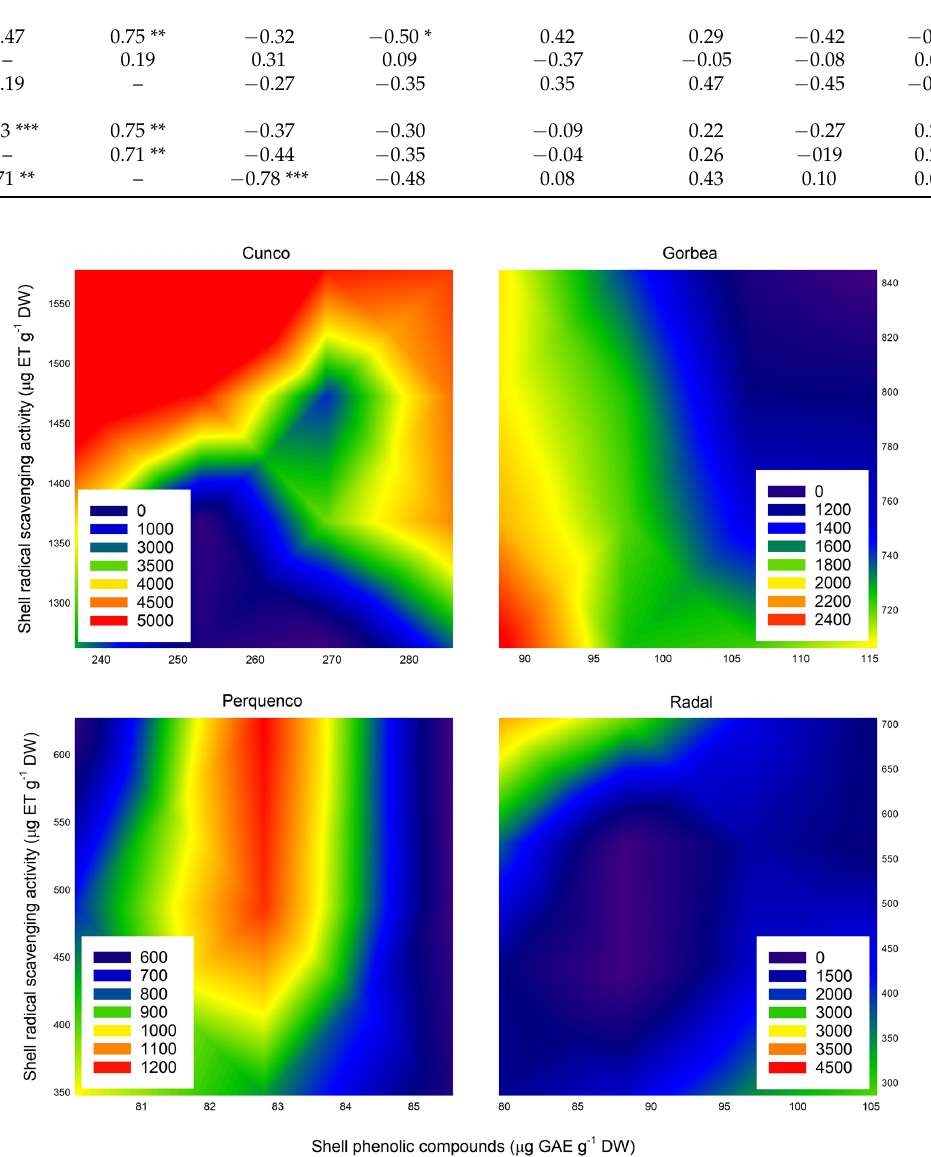
Figure 6. Relationships among shell AC (µmol TE g − 1 DW), RSA (µg TE g − 1 DW), and TPC (GAE µg g − 1 DW) in the shells of TDG hazelnuts after the foliar spraying of Ca, Mg and K in four orchards in the La Araucanía region.